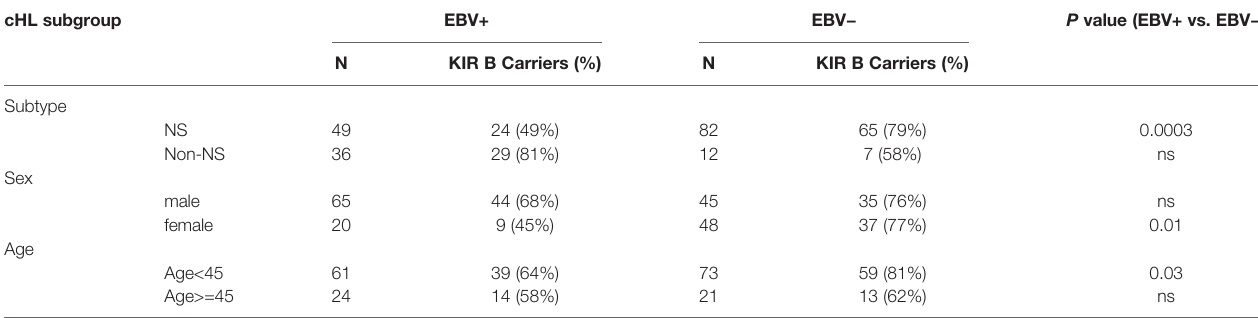
NS, nodular sclerosis; ns, not signi fi